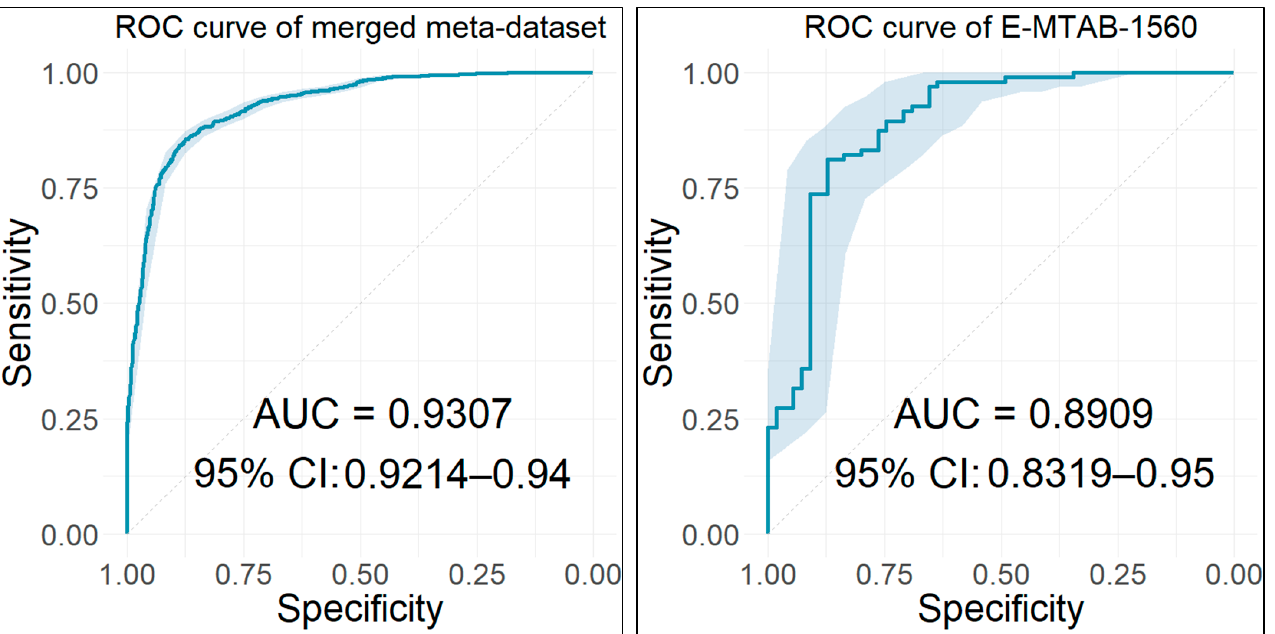
Figure 30. Validation of the diagnostic models, using the nine key biomarker genes as features, by ROC curve analysis on the merged meta-dataset ( n = 606) and on external validation E-MAT-1650 dataset ( n = 30).